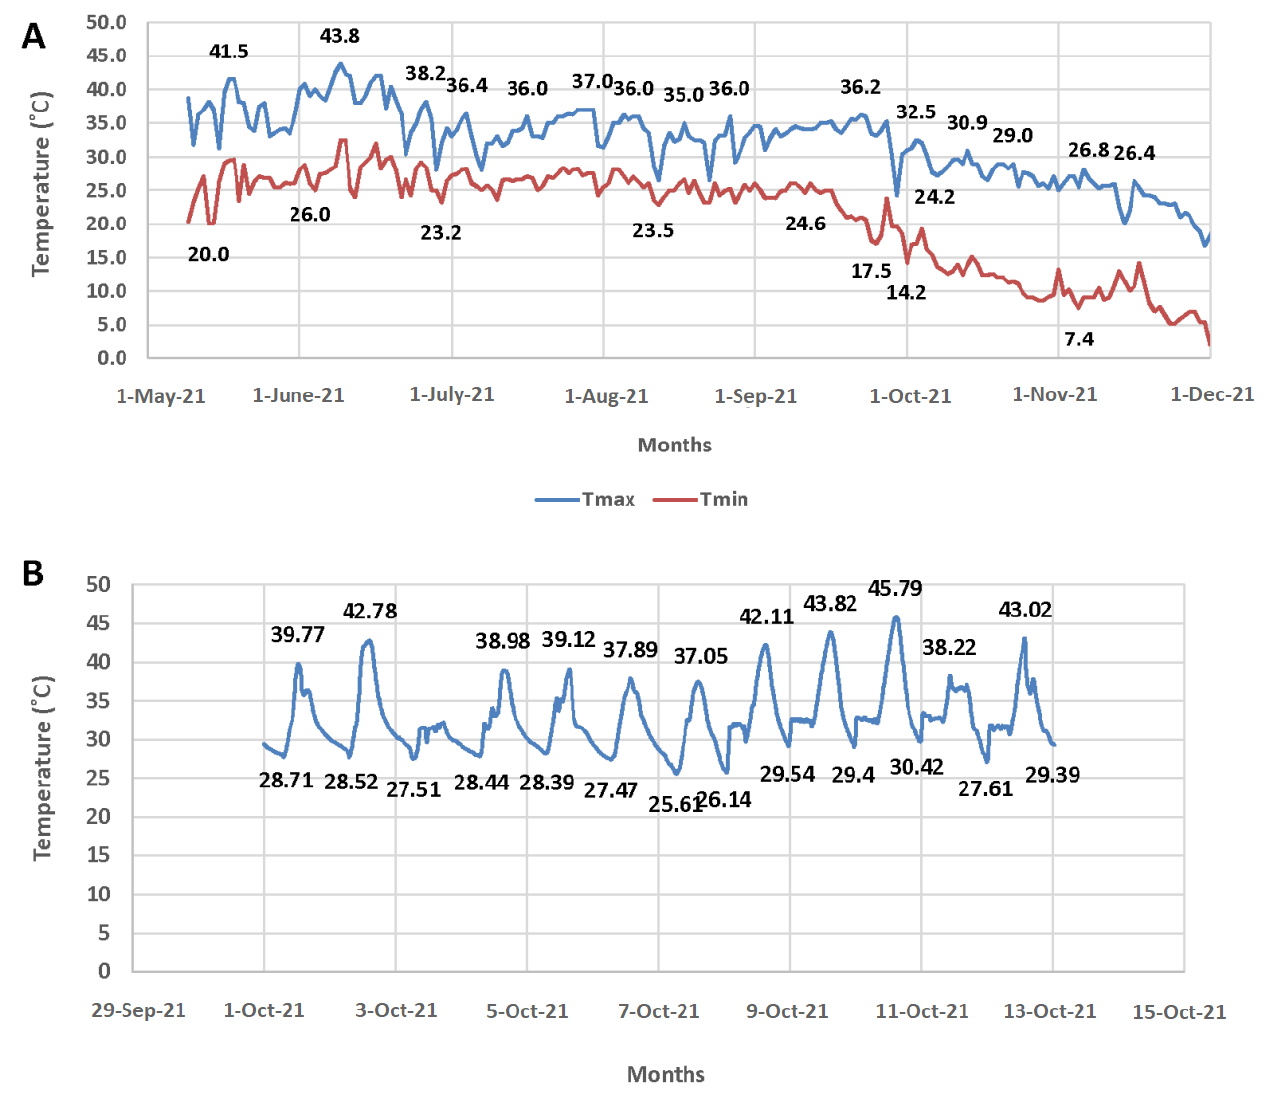
Figure 1. The figure illustrates the ambient temperature ( A ) and high temperature (HT)maintained during the course of experiment ( B ). Each data point represents the average of three replications.